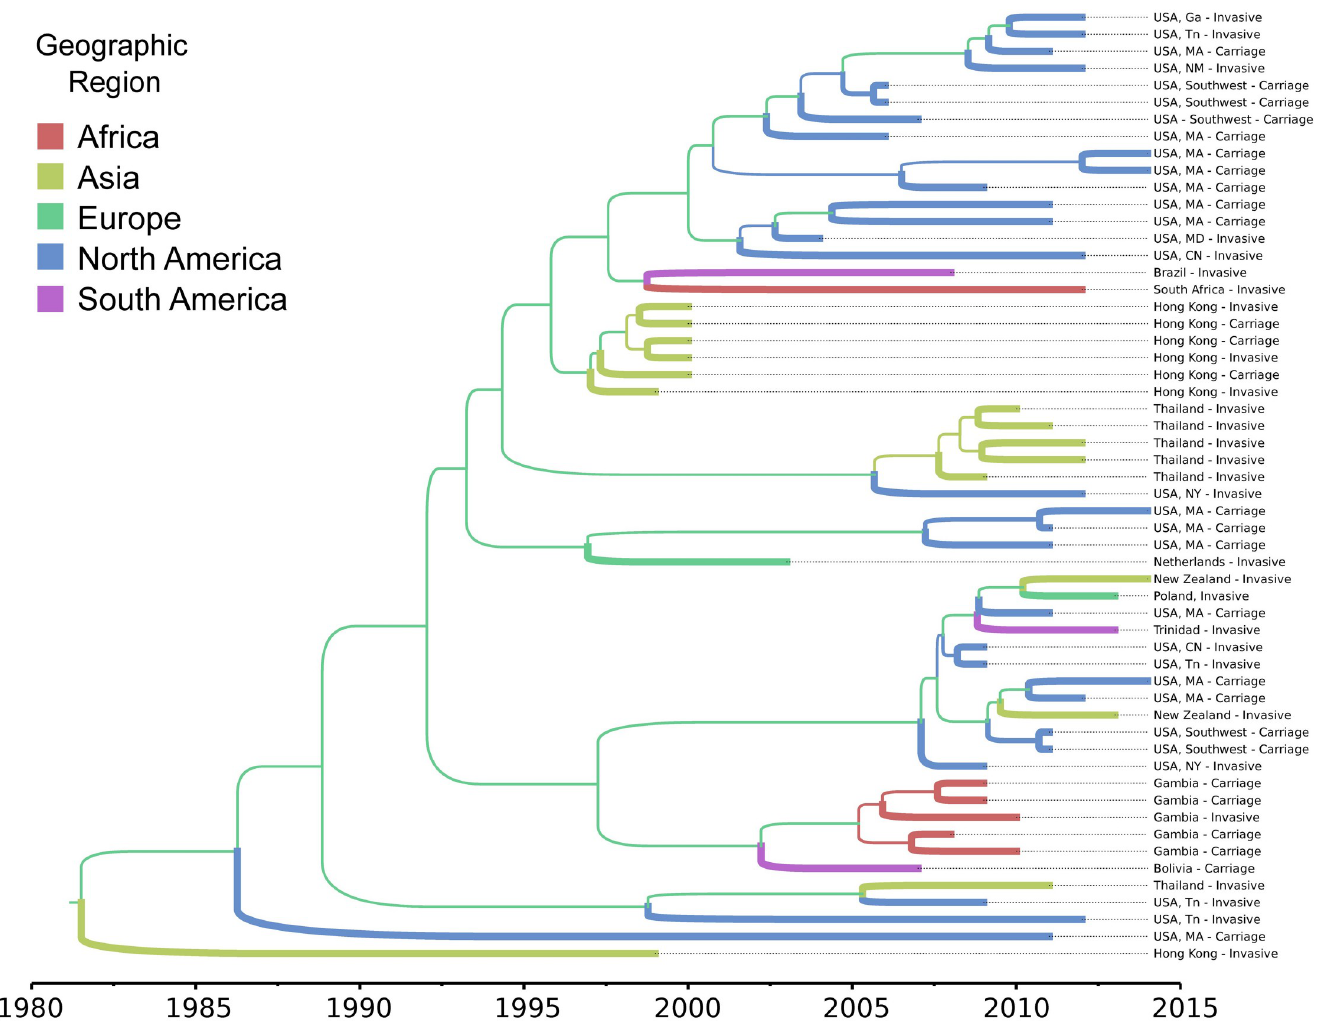
Fig 4. Maximum clade credibility, time-scaled phylogeny of CC180 serotype 3 (PMEN31) Clade II isolates estimated using the structured coalescent model implemented in BEAST2. Branches are colored by geographic region and thickness is scaled values of posterior probabilities for geographic migration. Posterior probabilities for internal branches were all < 0.30, precluding assessment of ancestral geographic